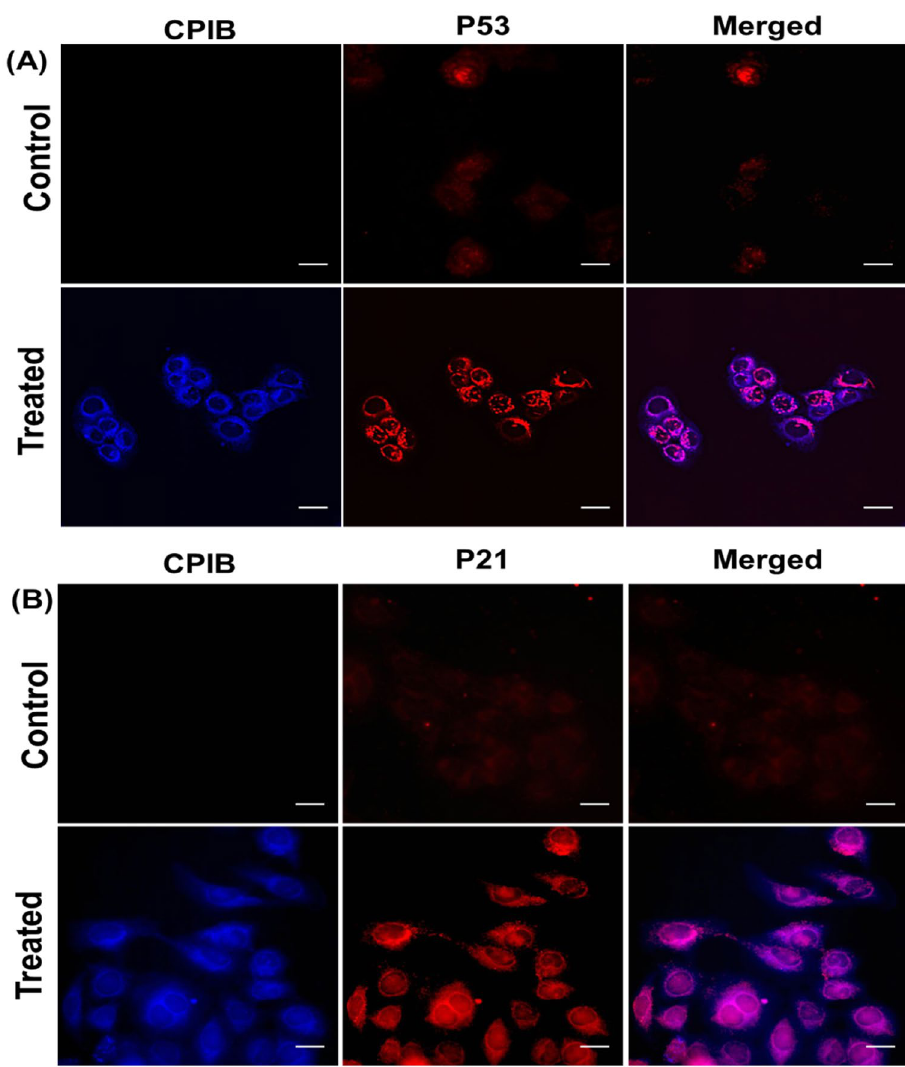
Figure 8. Immunocytochemistry assays confers apoptotic protein expression on treatment with CPIB ( A ) Immunocytochemistry experiment shows higher activation and localization of p53 proteins in MCF-7 cells treated with CPIB (5 μM) as compared to control signifying activation of anti-cancer pathway. Scale bars correspond to 20 μm. ( B ) Experiment shows higher activation and localization of p21 proteins in MCF-7 cells treated with CPIB as compared to control. Scale bars correspond to 20